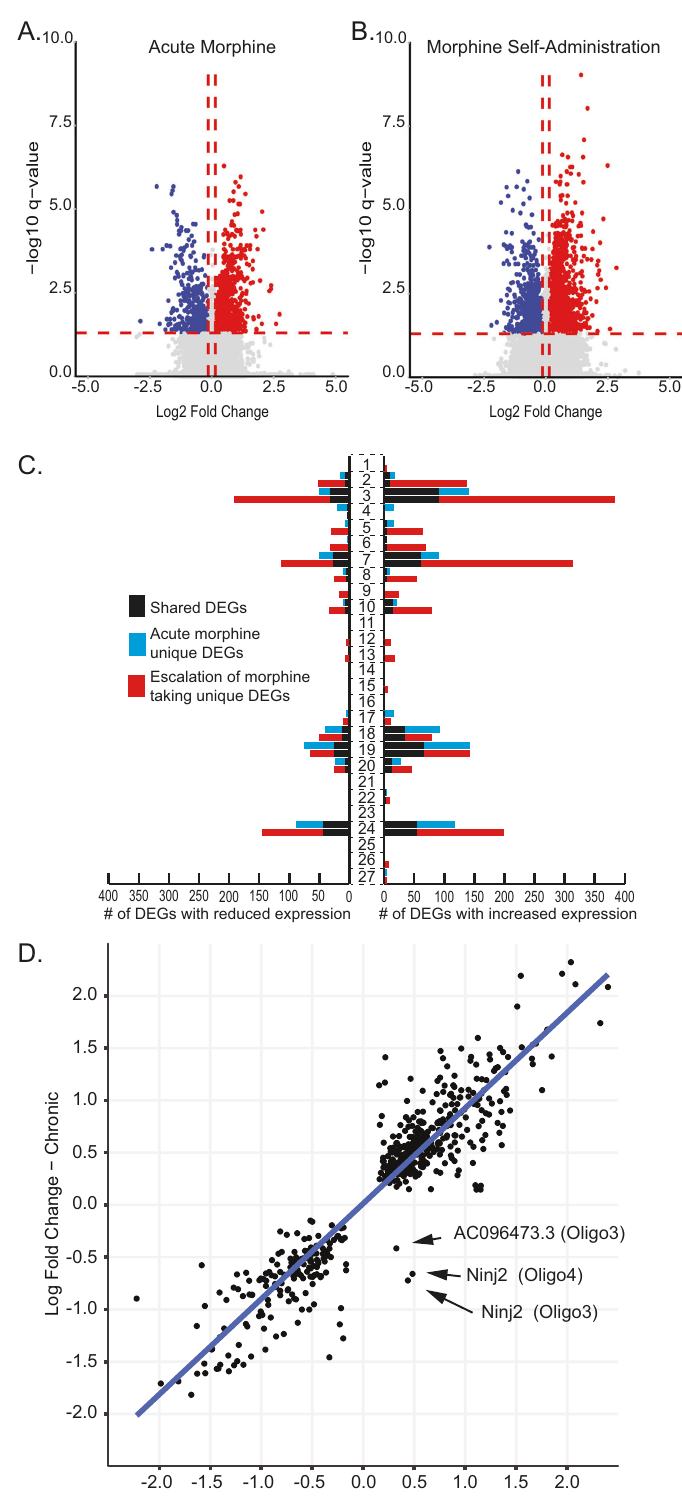
Fig. 3 Differential expression. Volcano plots depicting the downregulated (blue) and up regulated (red) differential expressed genes (DEGs) from the acute morphine treatment group ( A ; n = 1106 DEGs) or the morphine self-administration ( B ; n = 2453 DEGs) experiment. C A stacked bar graph depicting the number of downregulated (left) or upregulated (right) shared (black bars) and unique (blue or red bars) DEGs per cluster. D Of the 514 differential expression event shared between the acute morphine and morphine self-administration groups, gene expression was altered in the same direction of effect in nearly all instances. Three examples of gene expression alteration changing direction of effect were identi fi ed between the acute and self-administration